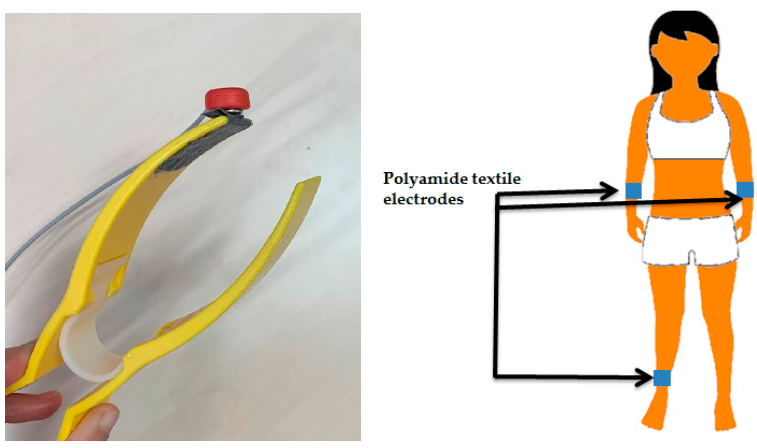
Figure 6. The set-up of electrocardiogram (ECG) measurement.